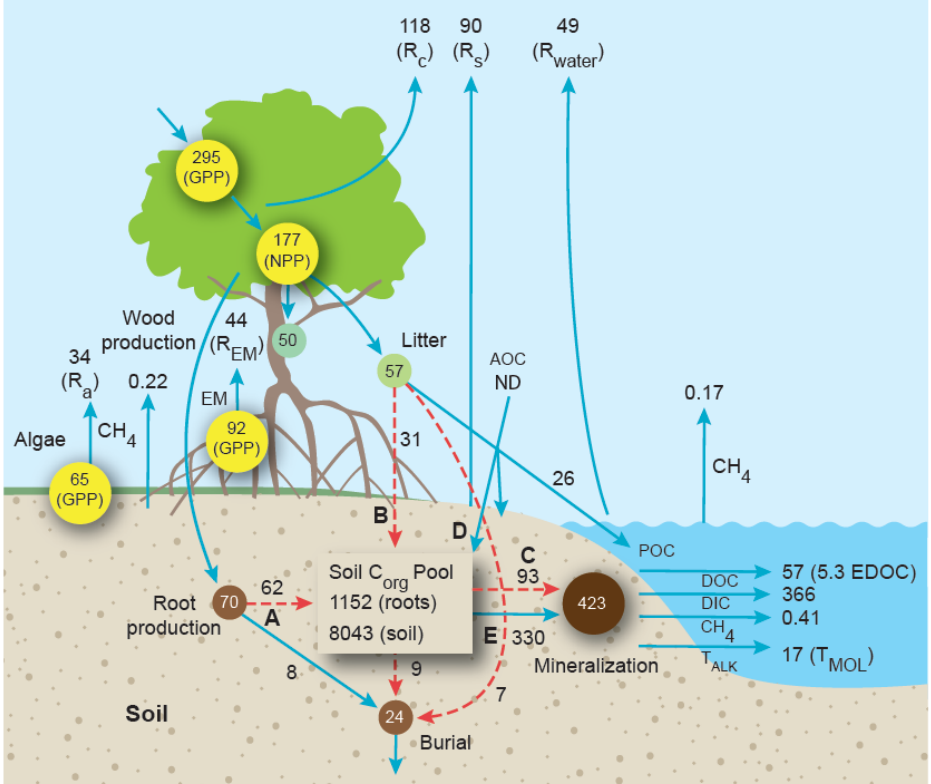
Figure 2. Blue carbon flow and standing stocks through the world’s mangrove ecosystems, updated from Alongi [18,74,76], assuming a global mangrove area of 147,359 km 2 [65]. Carbon fluxes are Tg C a −1 . Total alkalinity flux is Tmol a −1 . Solid blue arrows represent mean values based on published data (see text for explanation, Tables 1 and 2). Dashed red arrows are mean values estimated by difference. The soil C ORG pool (roots + soil) to a depth of 1 m is represented as a box in the forest floor with units of Tg C. Abbreviations: GPP = gross primary production; NPP = net primary production; R a = microalgal respiration; R EM = epiphytic macroalgal respiration; EM = epiphytic macroalgae; AOC = allochthonous C ORG input from phytoplankton, seaweed, seagrass, coral reef, and upstream terrestrial C4 plant detritus, etc.; R C = canopy respiration; R S = surface soil respira- tion; R WATER = waterway respiration; DC = dissolved carbon; POC = particulate organic carbon; DIC = dissolved inorganic carbon; DOC = dissolved organic carbon; EDOC = exchangeable dissolved organic carbon; CH 4 = methane; ND = no data. Total subsurface lateral DC flux from the forest floor (423 Tg C a − 1 ) = ‘C’ (93 Tg C a − 1 ) + ‘E’ (330 Tg C a − 1 ), where ‘C’ is the sum of fluxes ‘A’ (roots) + ‘B’ (litter). Flux ‘E’ = unquantified input from allochthonous C ORG (‘D’) plus total DIC production from the SOC pool, including unquantified DC flux from deep ancient deposits. These porewater